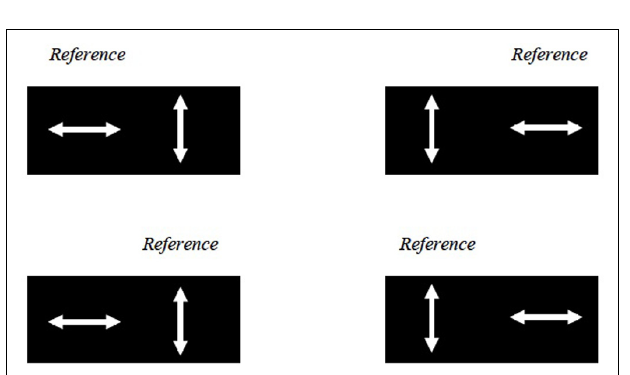
FIGURE 4 |The balanced attention version of the experiment. Here the LL UDLR condition is used as an example.The reference motion could either be presented in the left or right half of the screen, and could either be up–down or left–right motion (and in other conditions not illustrated here, the up-right motion as well).These four combinations were presented in random order in four